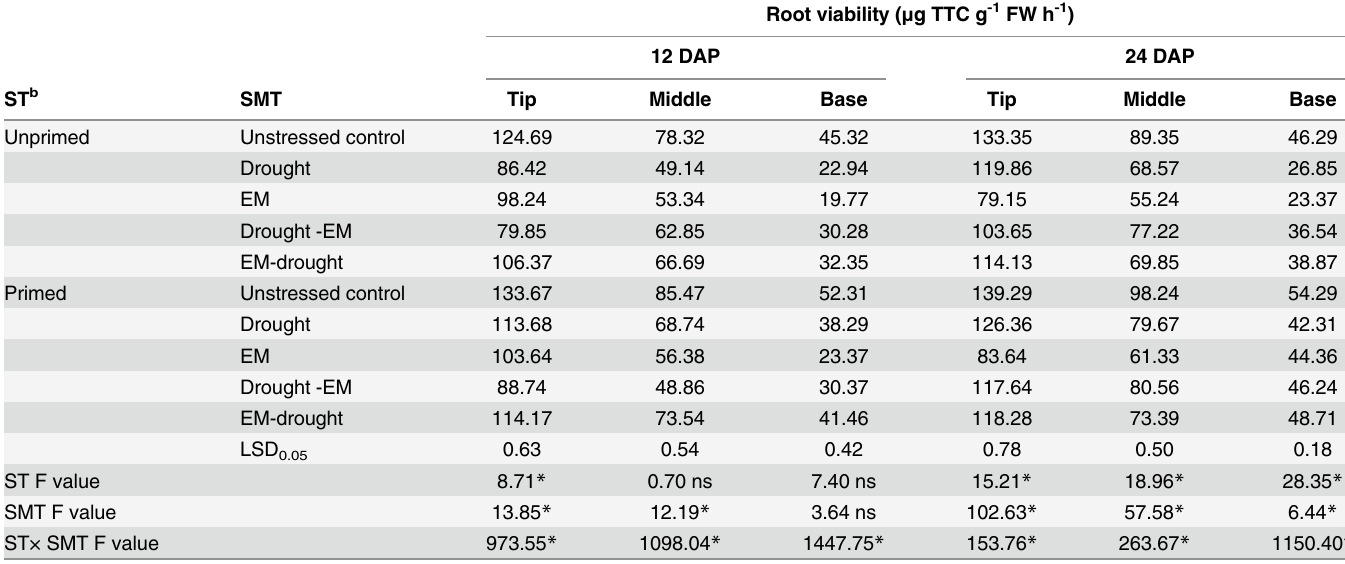
Table 4. Effect of seed priming with PEG and soil moisture stress on sorghum root viability.a